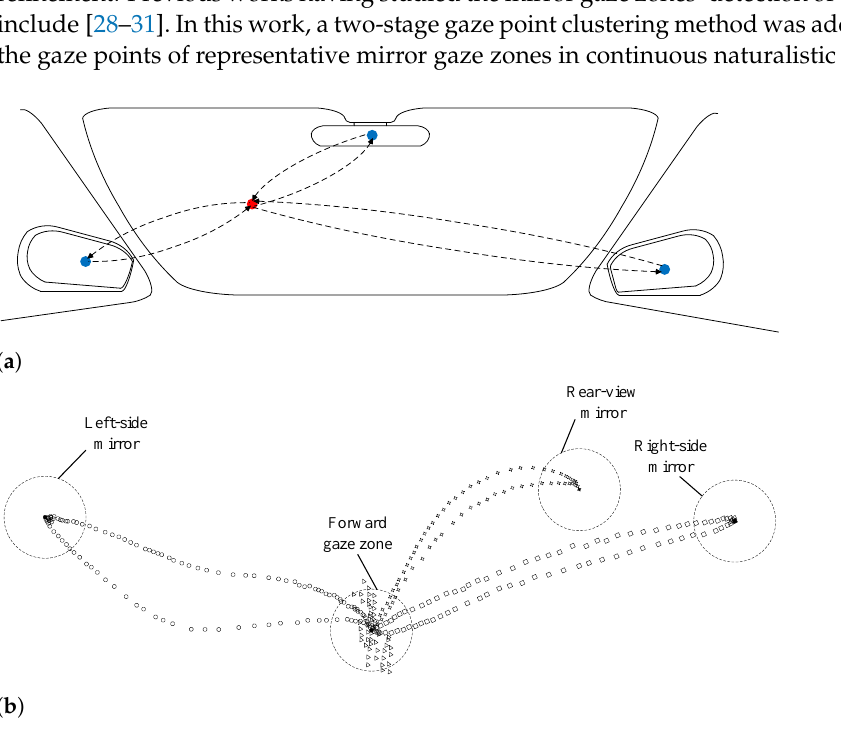
Figure 2. Typical eye glance allocation of mirror-checking behavior. ( a ) Schematic view of eye glance allocation. ( b ) Real-world examples in the gaze points space. Intuitively, the glance allocation for each mirror-checking behavior is discrete. The triangles denote the gaze points when the driver is facing the frontal area in the vehicle, and the circles, rectangles, and four-pointed stars denote the features’ trajectory when the driver turns to the left-side mirror, right-side mirror, and rear-view mirror, respectively. Here, the furthest feature points are used as the representative candidates for the driving